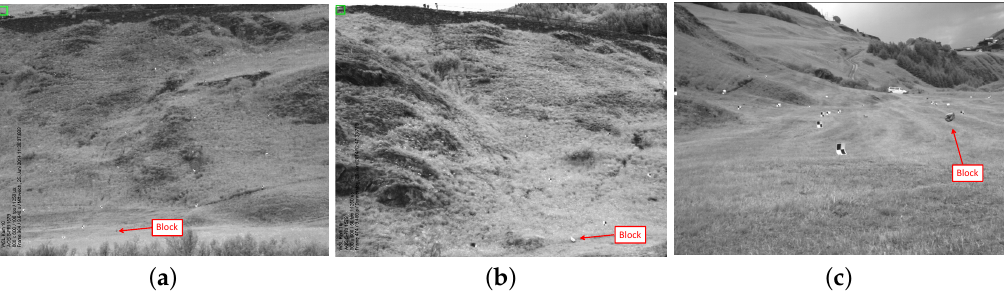
Figure 8. The different video views: ( a ) the whole test slope from the opposite valley side; ( b ) oblique view to the steep hill section of the test slope and ( c ) lateral view of a block in the runout zone. The subfigures give an impression on the difficulties if a block has to be identified: in ( a , b ) the block is barely visible whereas ( c ) shows a well visible